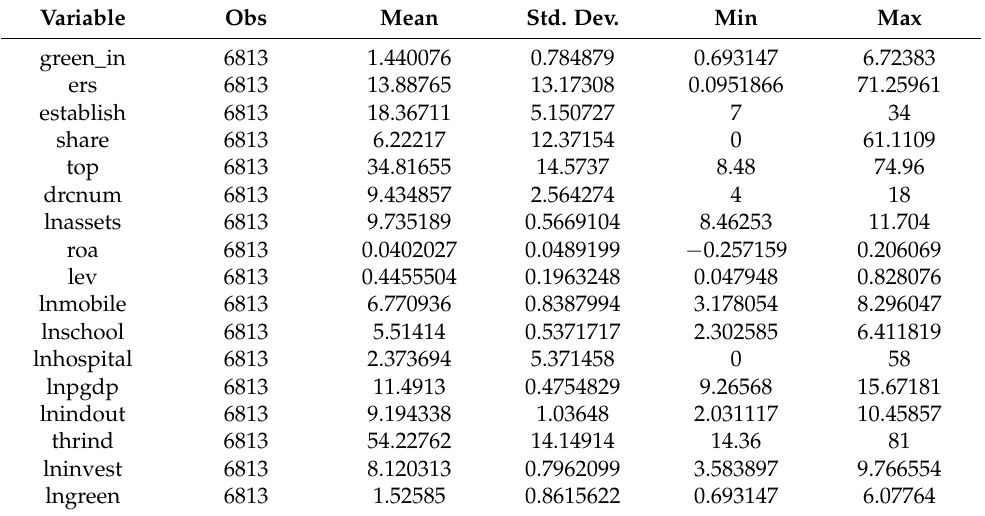
Table 4. Descriptive